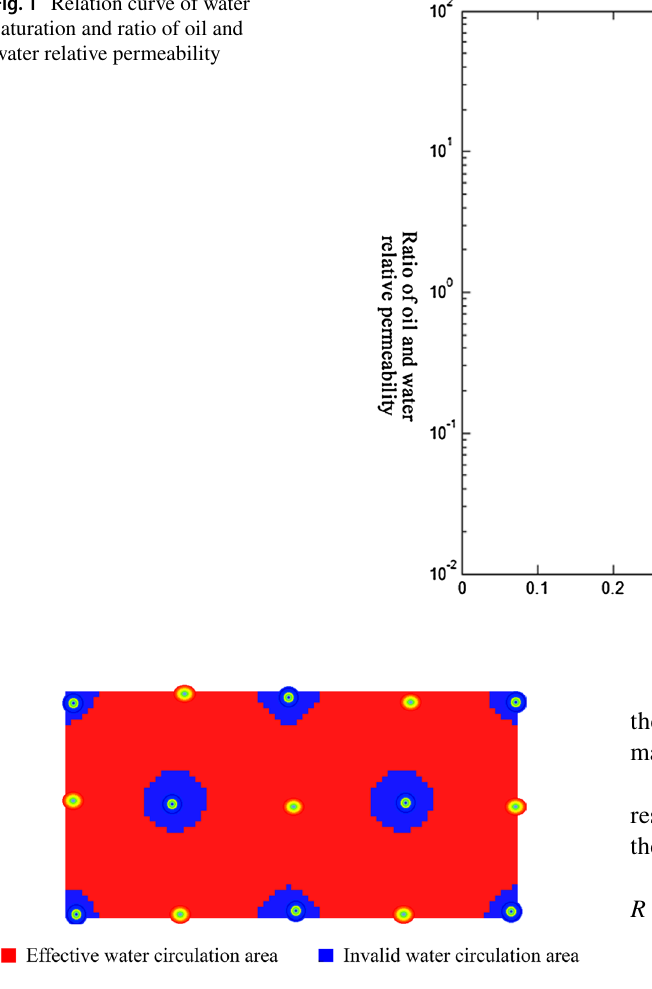
Fig. 2 The distribution map of the invalid water circulation area and the effective water circulation area